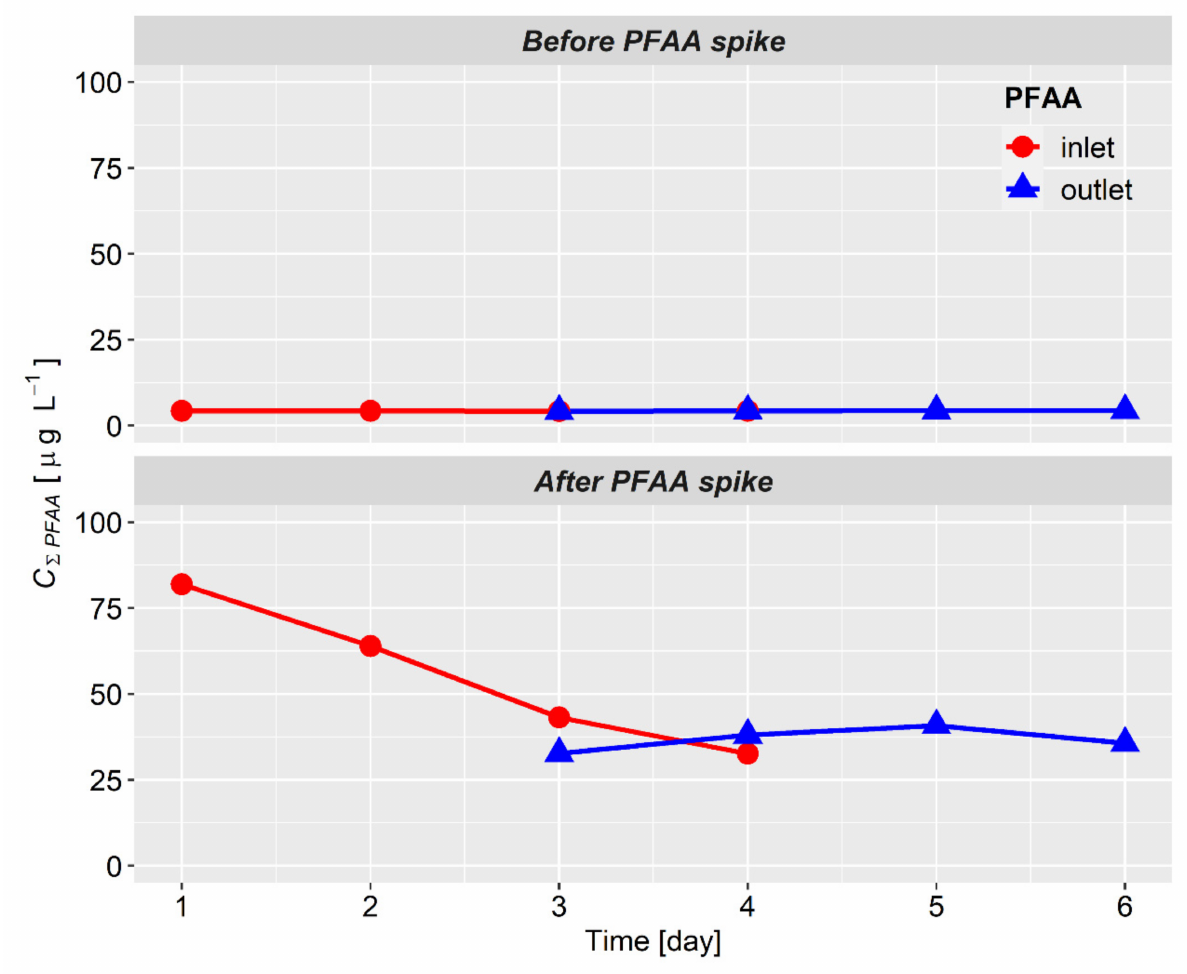
Figure 2. PFAA total concentration before the PFAA spike ( top panel ) and after the PFAA spike ( bottom panel ). The red markers indicate the values of the inlet averaged daily samples whereas the blue markers indicate those of the